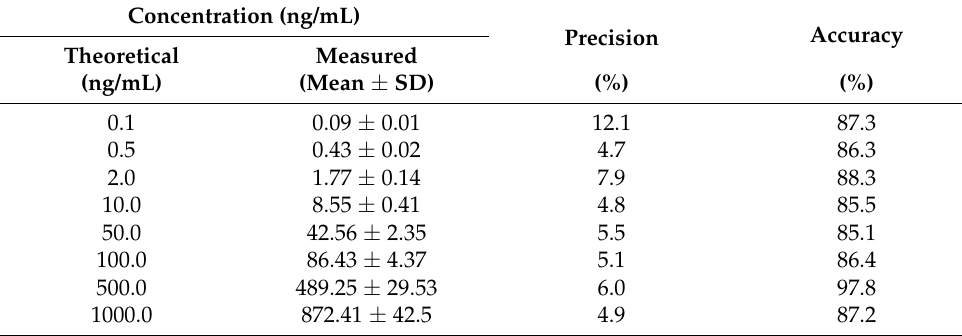
Table 1. Average of Plasma Standard Calibration Curve of Tamatinib.